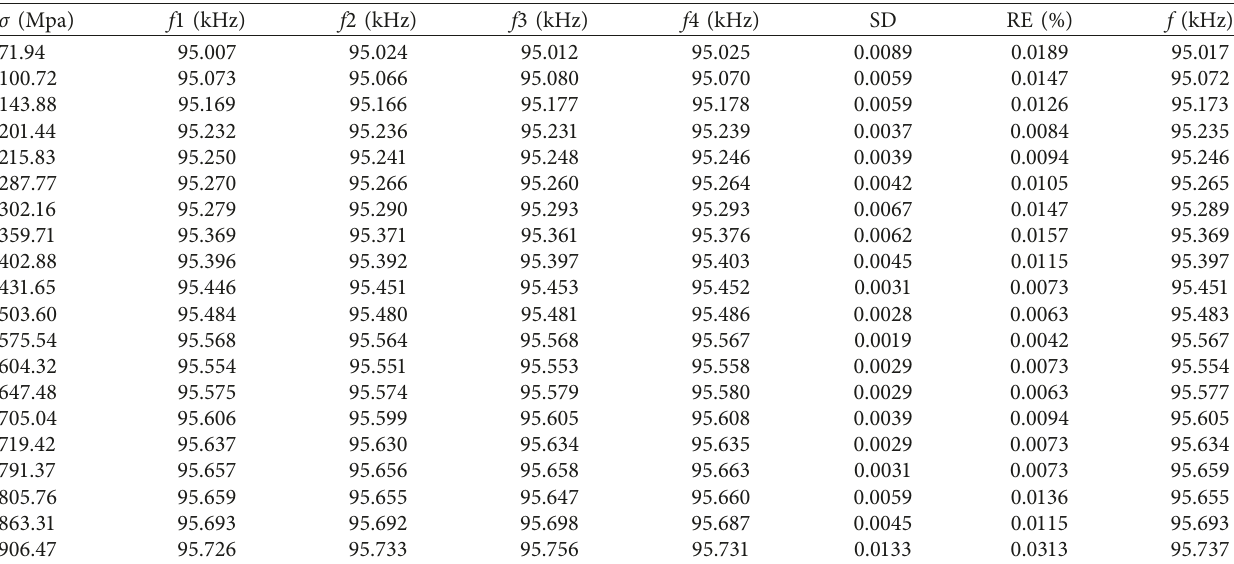
Table 5: 14m V 15.20 mm experimental data of steel